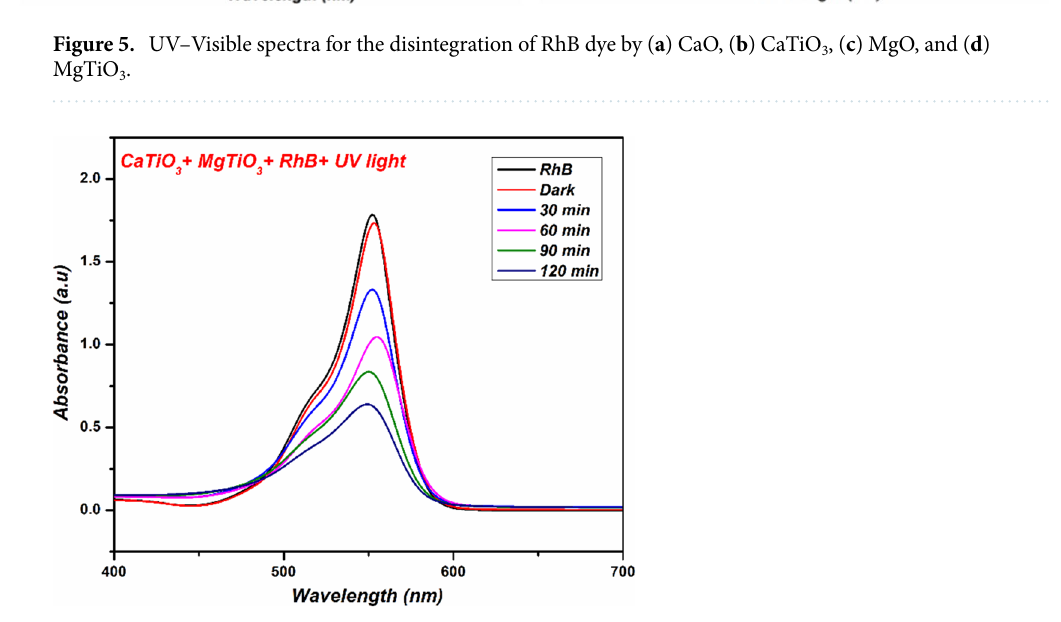
Figure 6. UV–Visible spectra for the disintegration of RhB dye by Mixture (CaTiO 3 + MgTiO 3